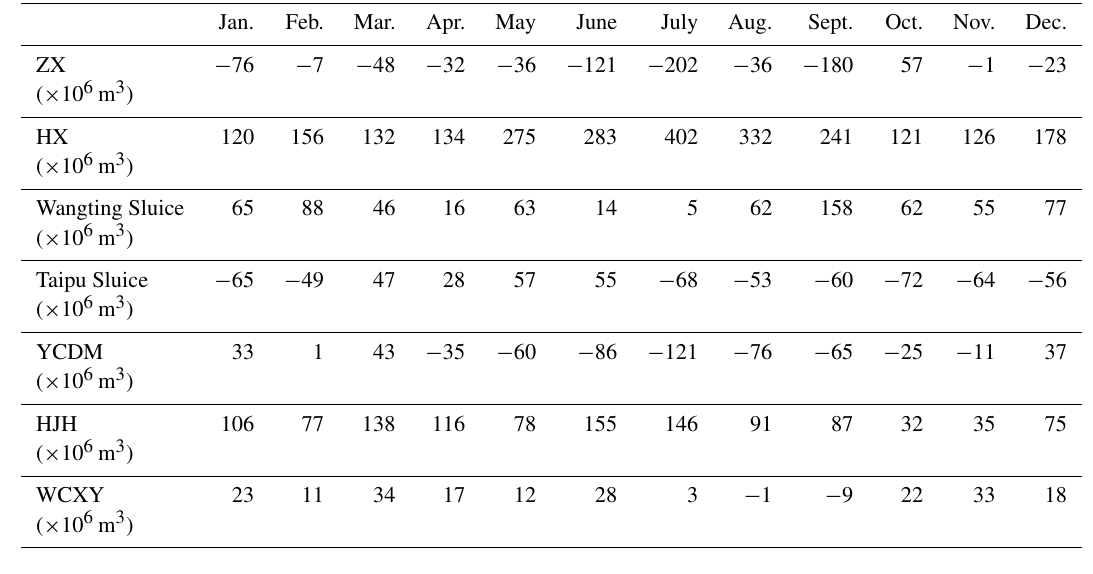
monthly water stage variation decreased more in August in abundant precipitation. Relationships between monthly pre- cipitation and water stage variation were demonstrated in Fig. 6. Accumulated precipitation amount more than 20.0 mm concentrated in flood season from 2002 to 2015, was se- lected in the P − P a − R curve making , which was demonstrated in Fig. 7. With the value of P a increased from 10 to 100 mm, the P − P a − R curve got closer to abscissa axis, and the upper part of curves were approximately parallel. Under the same precipitation amount with 50 mm, water stage increased 0.07 m when P a equals 10 mm water stage increased 0.08 m when P a equals 20 mm, water stage increased 0.09 m when P a equals 30 mm, water stage increased 0.095 m when P a equals 40 mm, water stage increased 0.11 m when P a equals 50 mm, water stage increased 0.13 m when P a equals 70 mm, and water stage increased 0.14 m when P a equals 100